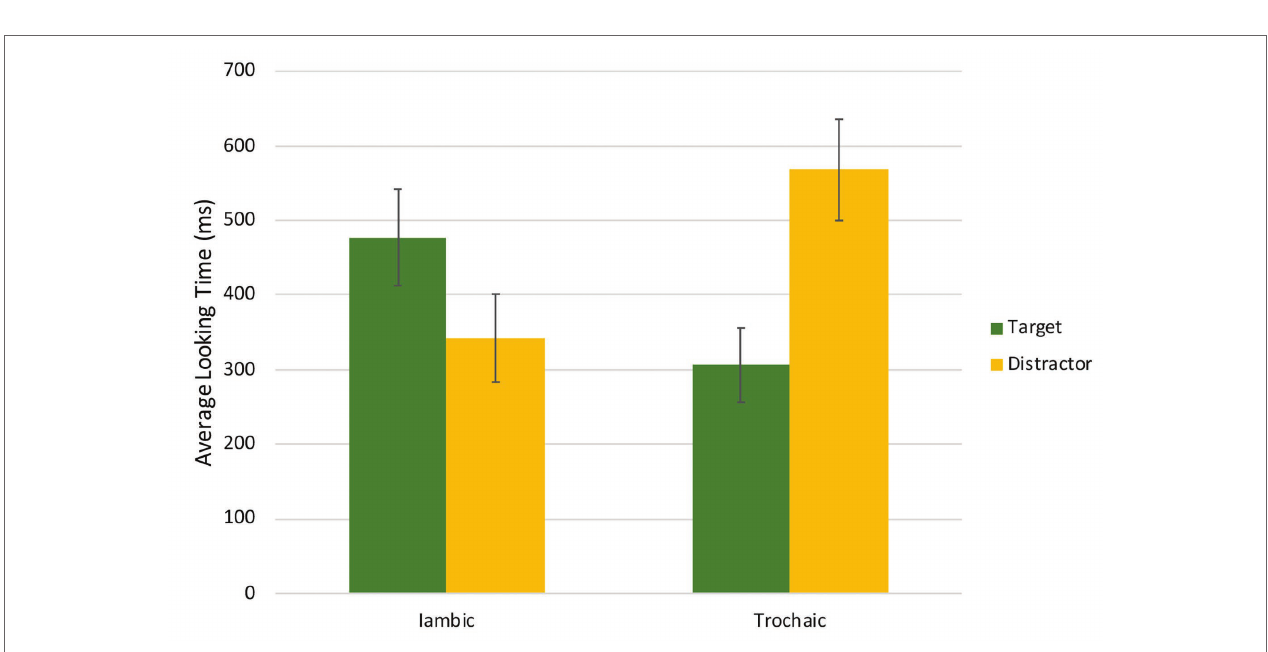
FIGURE 5 | Average looking times (in milliseconds) to the target and distracter sides for iambic and trochaic test trials. Error bars indicate the standard error of the mean